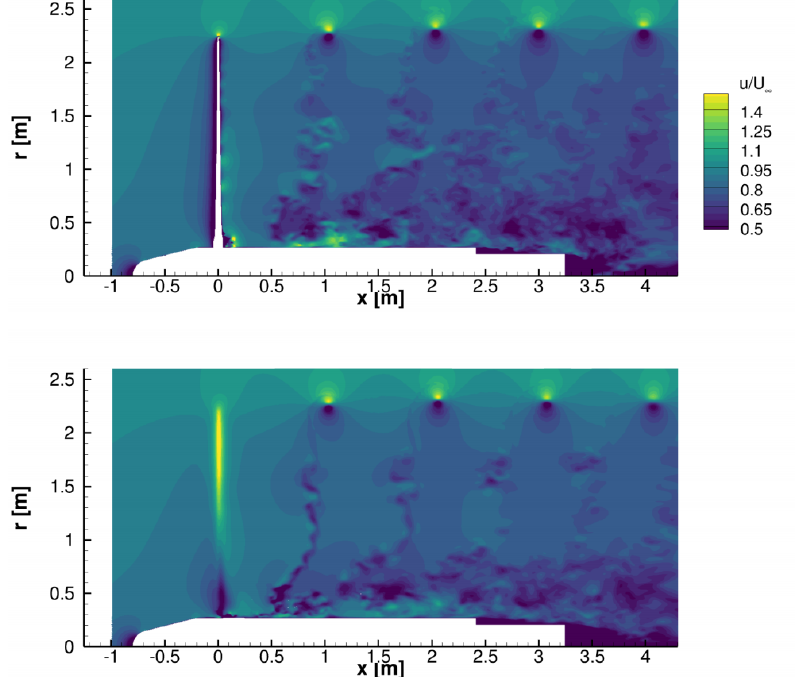
Figure 9. Comparison of instantaneous velocity in the blade plane. ( Top ) Geometry resolved simulation. ( Bottom ) AL simulation with anisotropic Gauss − Gumbel force distribution. Reprinted from [43] under Creative Commons Attribution 3.0 licence